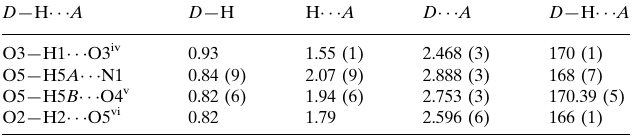
Hydrogen-bond geometry (A˚ , (cid:2)